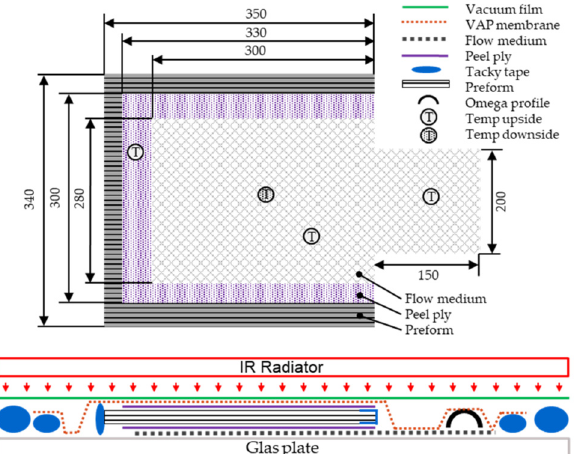
Figure 5. Schematic of the VAP infusion setup, preform size, blanks: flow medium and peel ply.